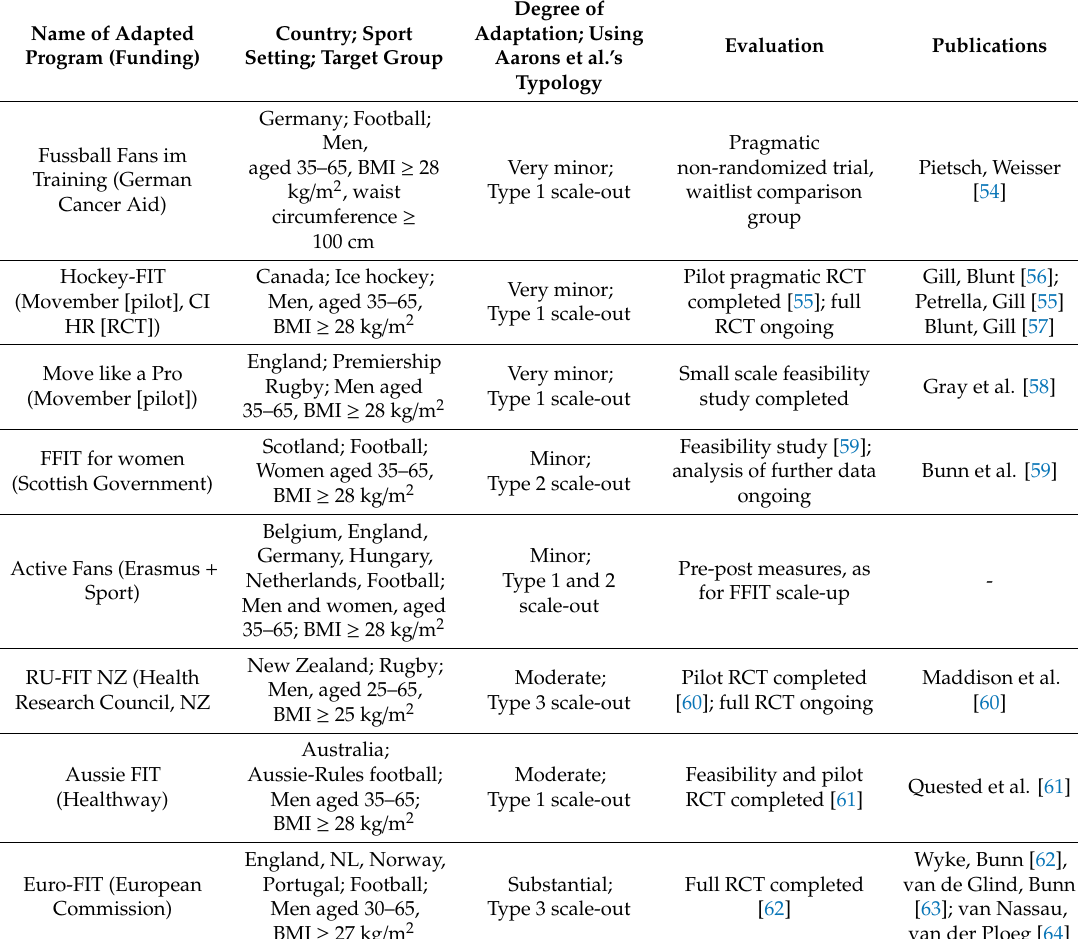
Table 5. Adaptation of FFIT in other professional sports settings, countries or target groups. Name of Adapted Program